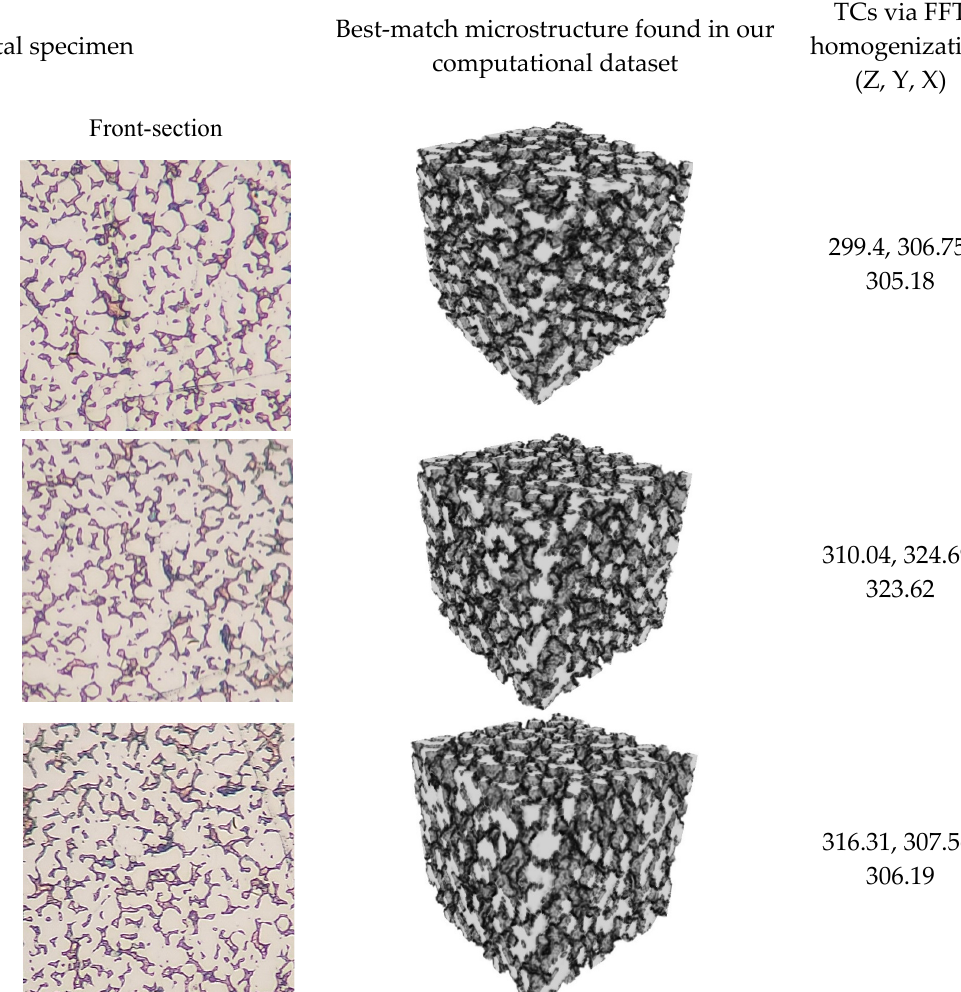
12 of 16 Figure 10. The high-level overview of our image processing algorithm.